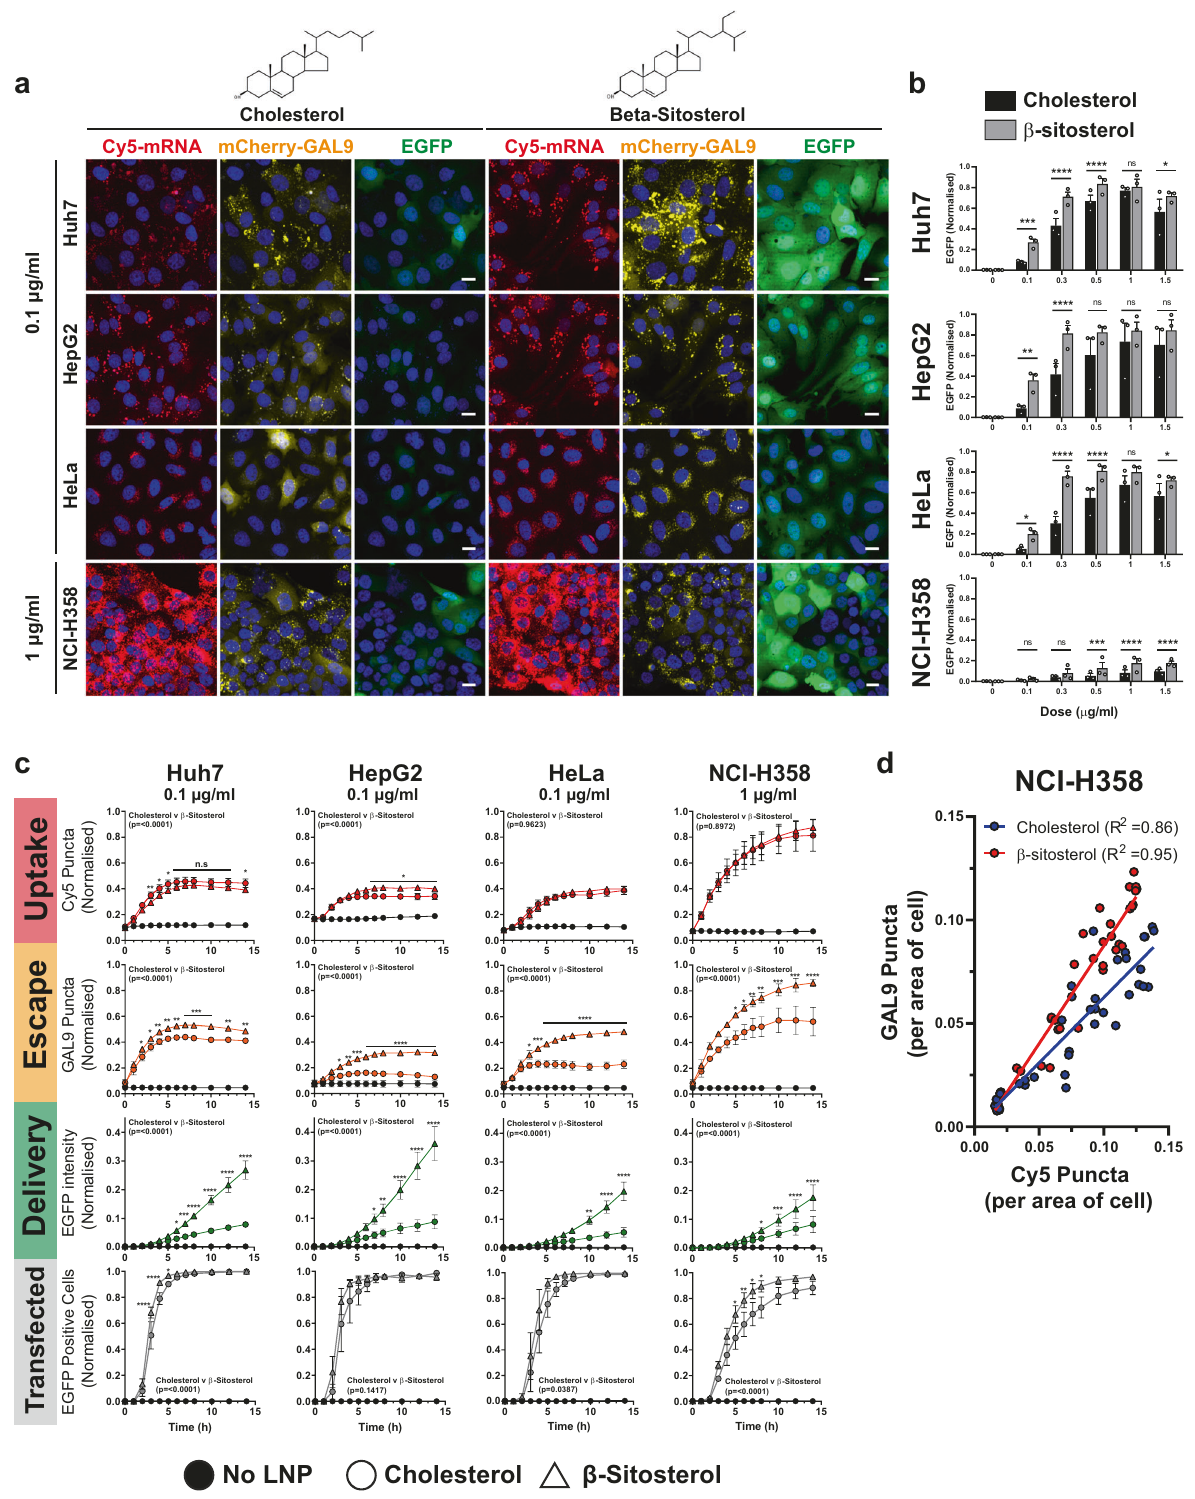
Fig. 5 β -Sitosterol modi fi es endosomal escape rate. a Huh7, HepG2, HeLa and NCI-H358 mCherry-GAL9 cells were dosed at indicated concentrations of MC3-LNPs formulated with cholesterol or β -sitosterol. Images are representative of 14 h post-dosing. Scale bar = 20 µ m. b Comparison of cell EGFP fl uorescent intensity at 14 h after incubation with Cholesterol or β -sitosterol particles in Huh7, HeLa, HepG2 and NCI-H358 cells across 0.1 – 1.5 µ g/ml doses. Values represent normalised EGFP intensity ± SEM from n = 3 independent experiments. c Quantitation of ( a ) examining the formation of Cy5 positive structures, mCherry-GAL9 structures and EGFP fl uorescence per cell over time. Values represent normalised means ± SEM from n = 3 independent experiments. Signi fi cance was determined in ( b , c ) for full 0 – 14 h time courses by two-way ANOVA followed by Tukey ’ s multiple comparison test where * p < 0.05, ** p < 0.01 *** p < 0.001, **** p < 0.0001 and ns not signi fi cant. d Comparison of total Cy5 or GAL9 puncta over time obtained from ( c ) for cholesterol or β -sitosterol particles in NCI-H358 cells. Linear regression carried out and R 2 values displayed on the